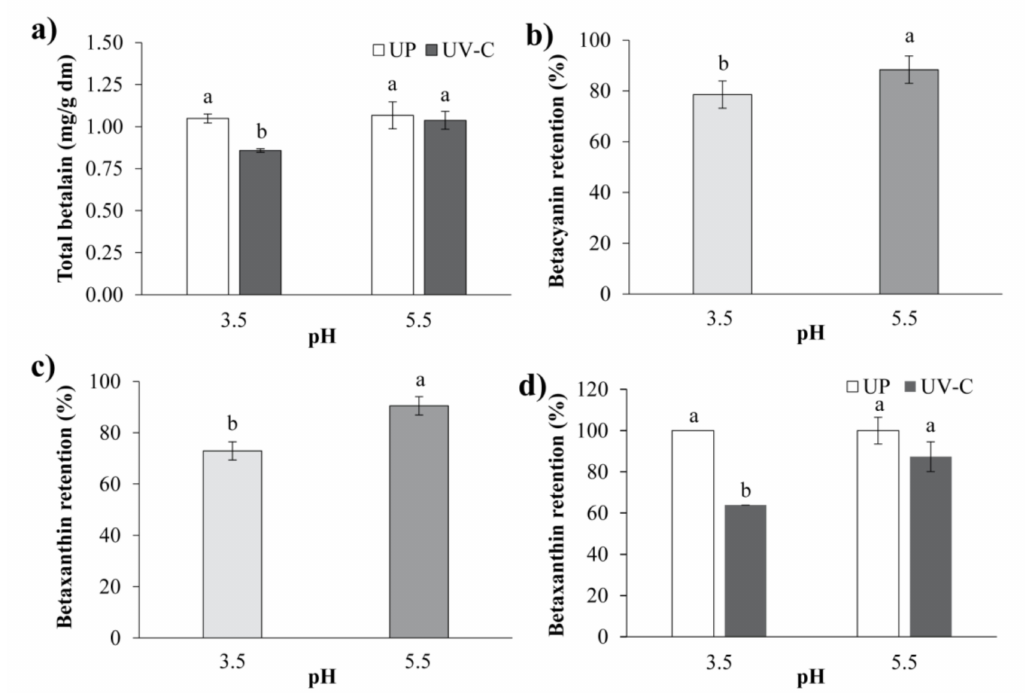
Figure 2. E ff ects on betalain-type pigments of the Aloe vera –pitaya blend. ( a ) E ff ect of pH on total betalains content of unprocessed (UP) and UV-C irradiated treatments. ( b ) E ff ect of pH on betacyanin retention (%BC). ( c ) E ff ect of pH on betaxanthin retention. ( d ) E ff ect of pH on betaxanthin retention (%BX) of unprocessed (UP) and UV-C irradiated treatments. For each figure panel, the di ff erent letters indicate significant di ff erences between the treatments at p <